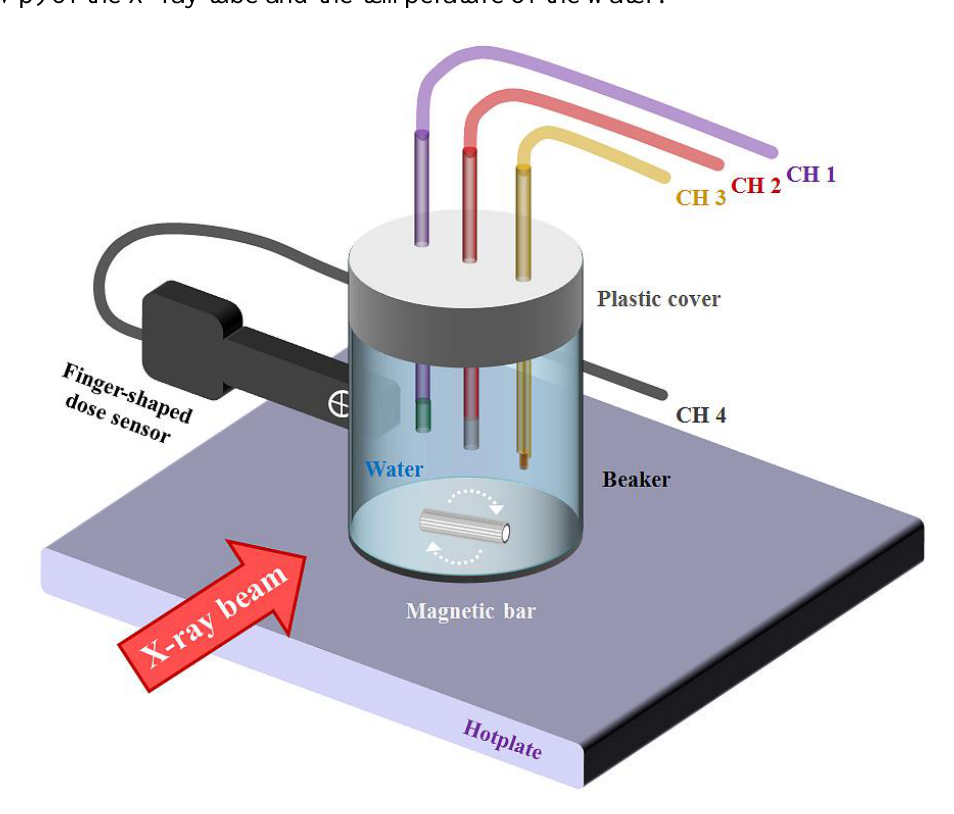
Figure 4. Detailed experimental setup using a hotplate with a built-in magnetic stirrer, a beaker of water and four different kinds of sensing